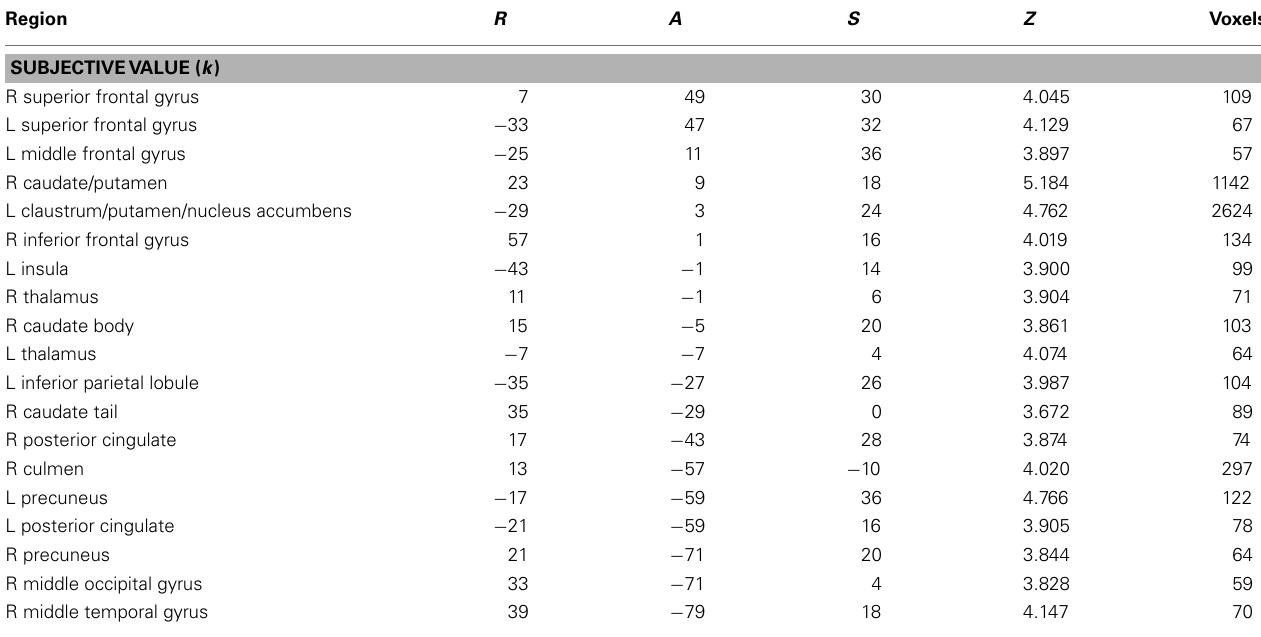
TableA1 | Brain regions representing subjective value using a hyperbolic model of discounting (with discounting parameter, k ) across all subjects.